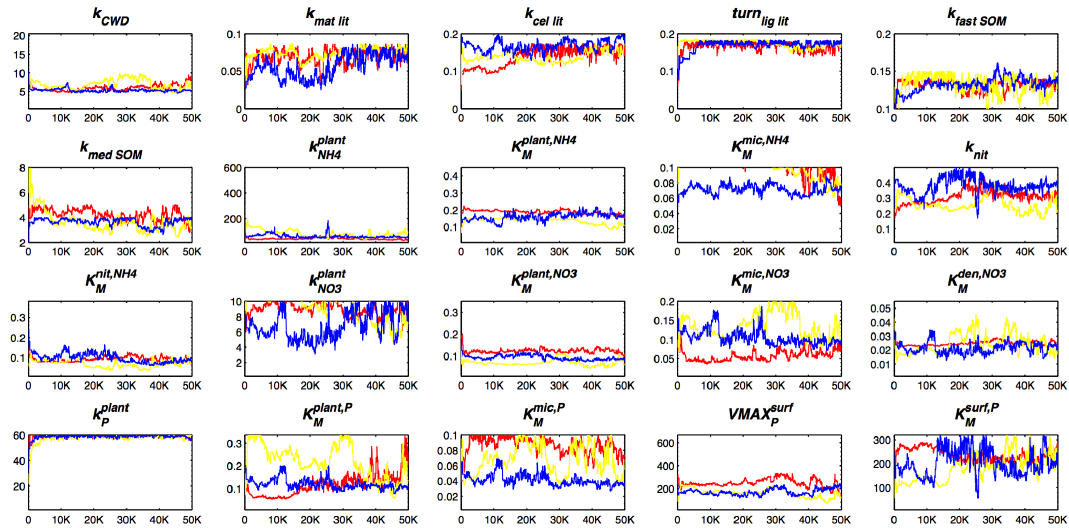
Figure A1. MCMC chain. Blue line represents the MCMC samples that are used to infer our model posterior parameters. Two other replicated MCMC calibrations (with different random number seeds) were conducted (yellow and red lines), in order to check the convergence of MCMC calibration.